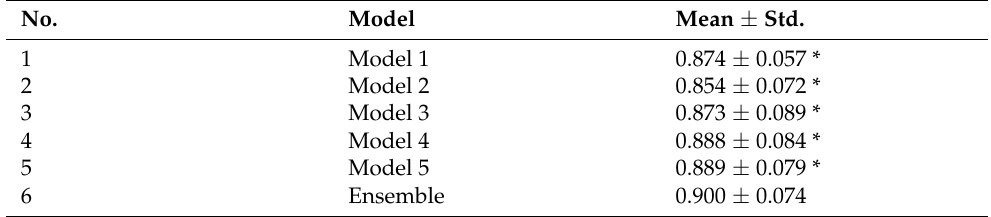
Table 3. Performance comparison with single and ensemble model in terms of dice coefficient for the anonymized dataset in South